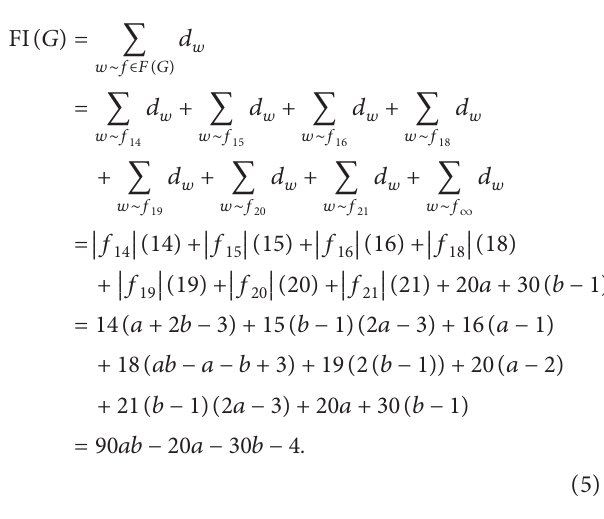
C − II [ a, 1 ]) , FI ( Si 2 3